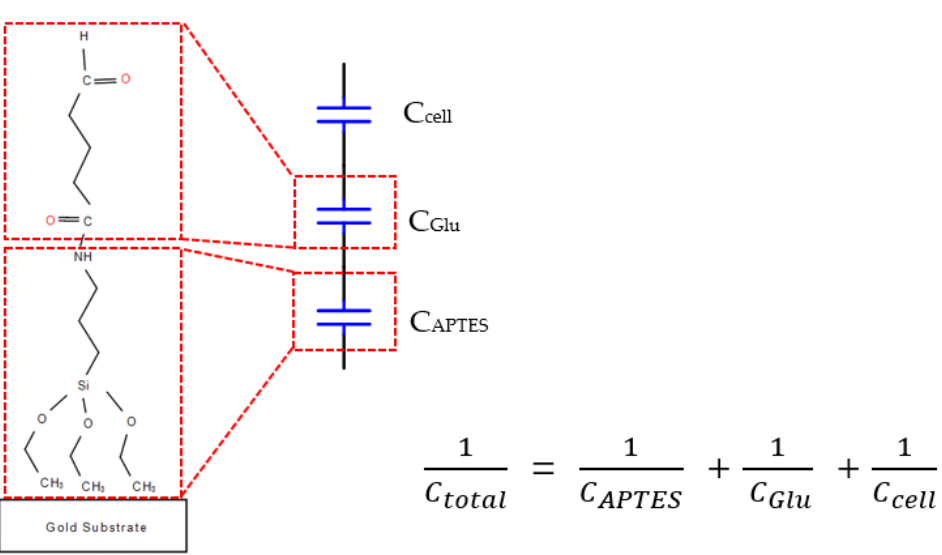
Figure 4. Chemical structure of (3-Aminopropyl) triethoxysilane (APTES) and glutaraldehyde immobilized on the surface. Here, C APTES is the capacitance of the APTES layer, C Glu is the capacitance of the glutaraldehyde layer, C cell is the capacitance of the cell layer, and C total is the total capacitance measured at the working electrode solution interface (modified from [17]).